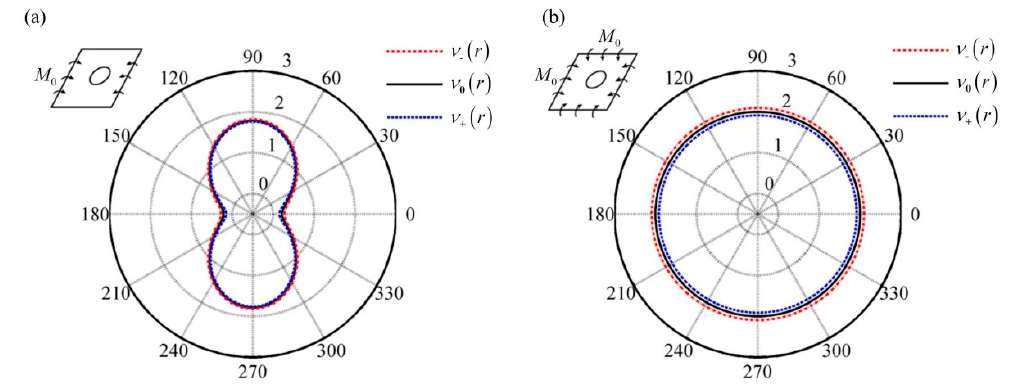
Figure 4. Distribution of moments M θ / M 0 around the hole for di ff erent varying Poisson’s ratio: ( a ) uniaxial bending; ( b ) balanced biaxial bending.